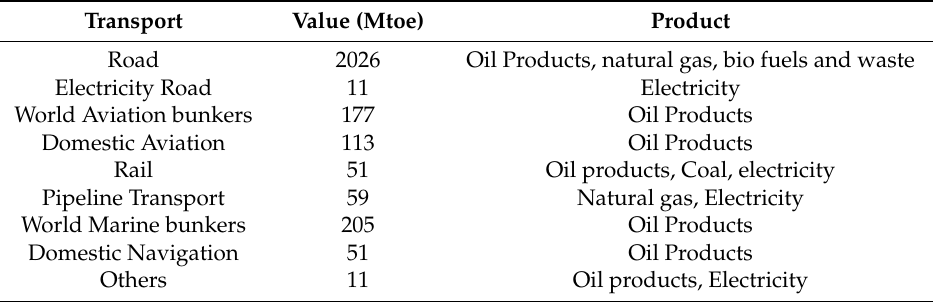
Table 1. Consumption of energy by transport [1].